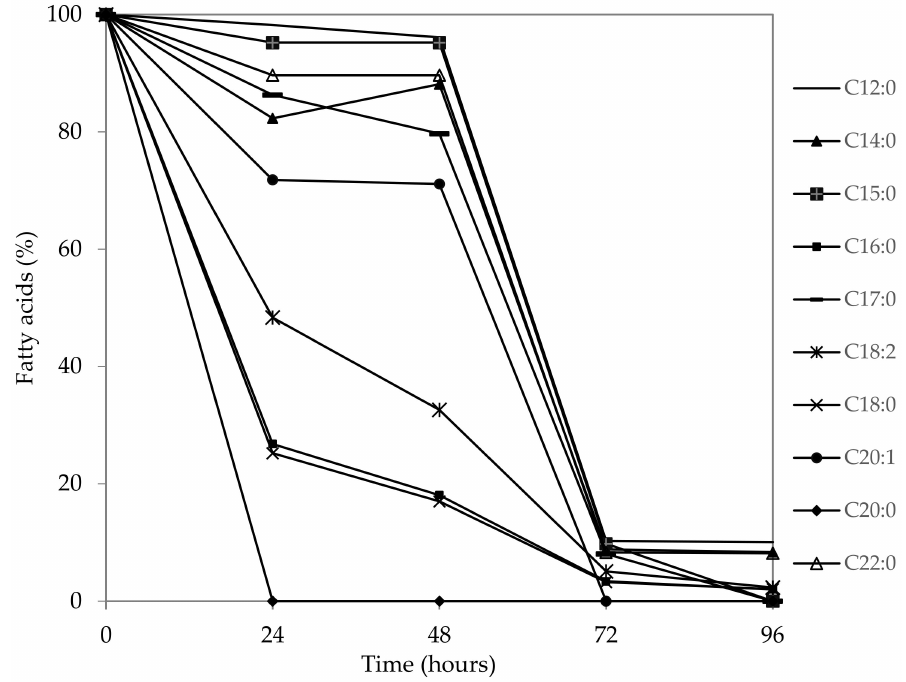
Figure 4. Consumption of fatty acids from residual guava seed oil by P. aeruginosa LBI 2A1. Cultiva- tion took place at 200 rpm and 37 ◦ C for 96 h of fermentation. Table 4. Homologues found in rhamnolipid produced by P. aeruginosa LBI 2A1 using guava seed oil as